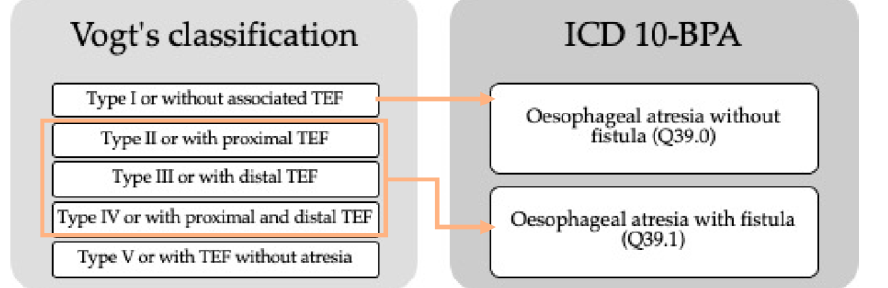
Figure 1. Comparison of Vogt’s classification and ICD10-BPA of oesophageal atresia. TEF: tracheoesophageal fistula.